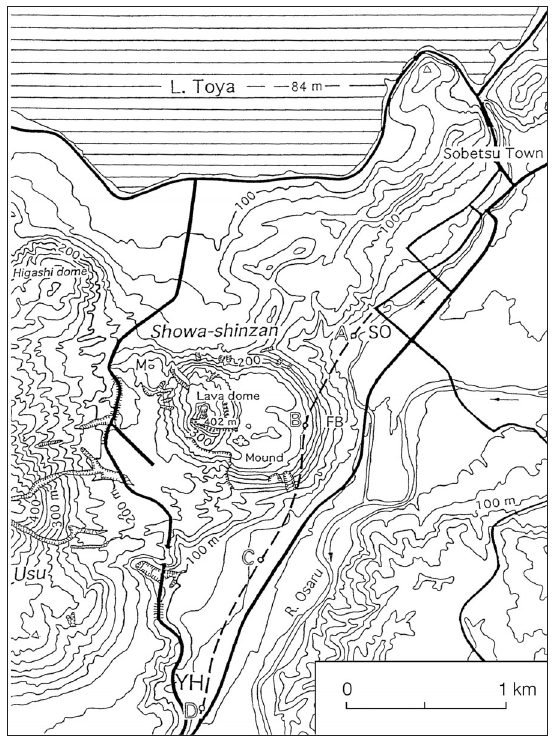
Fig. 5. Topographic sketch map of the 1944 lava dome area as of 2002. Contour interval, 25 m. Thick broken line indicates route of precise levels in 1944, projected on map of 2002; M, preexisting hill.